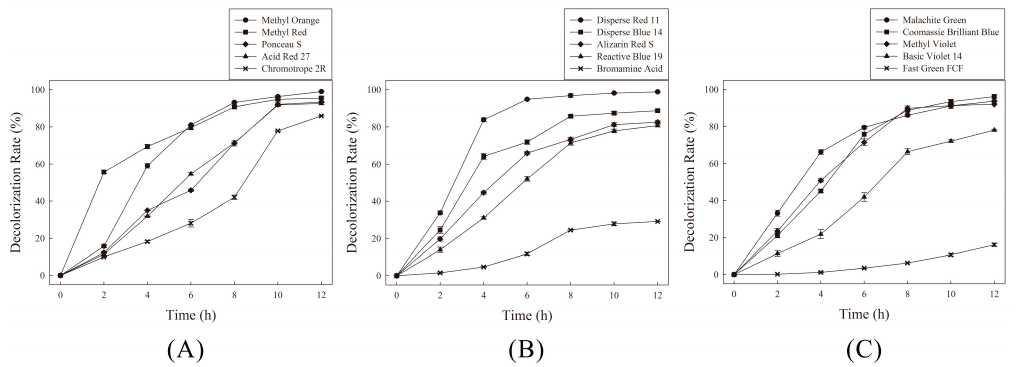
Figure 1. Decolorization of different azo, anthraquinone and triphenylmethane dyes (100 mg·L − 1 ) by